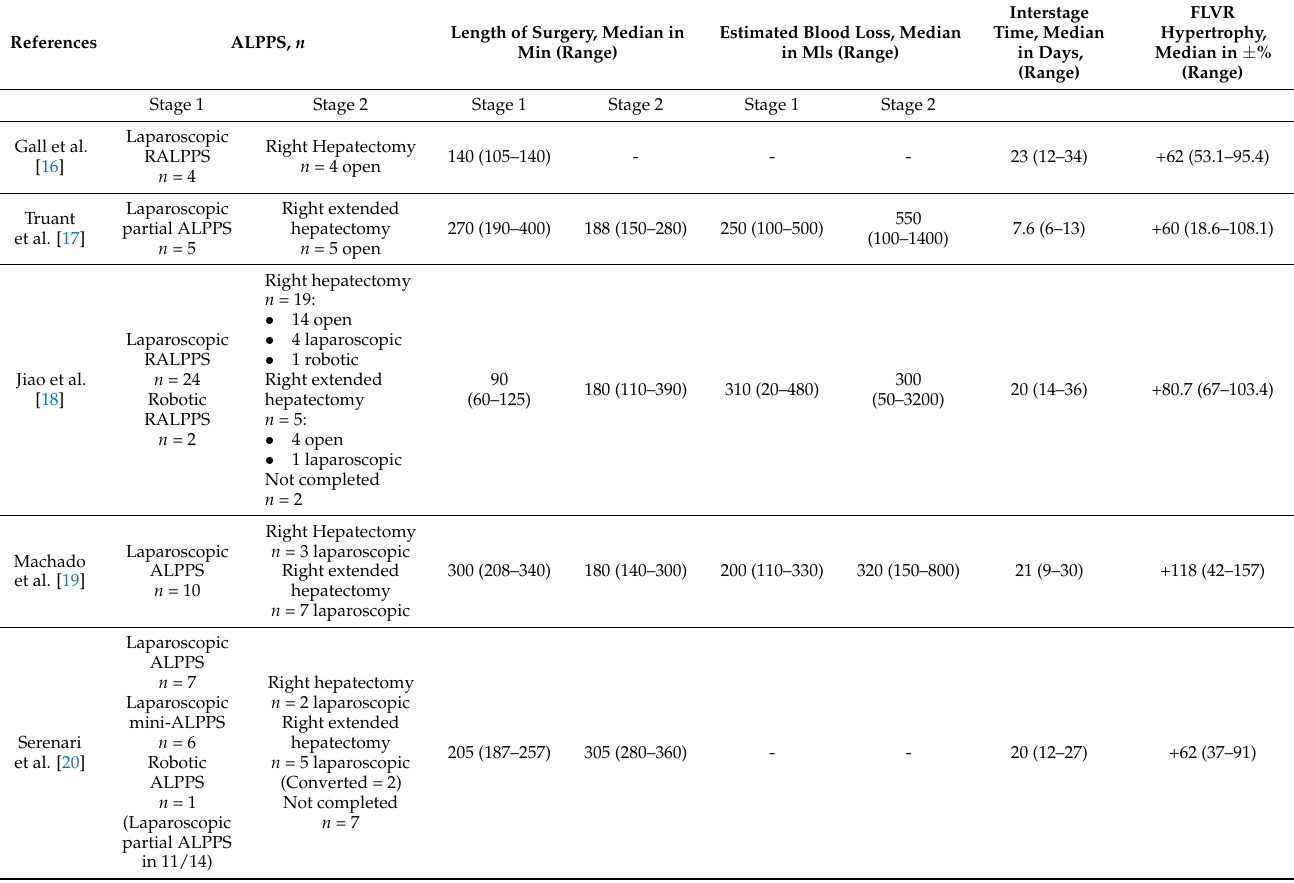
Table 2. Perioperative data